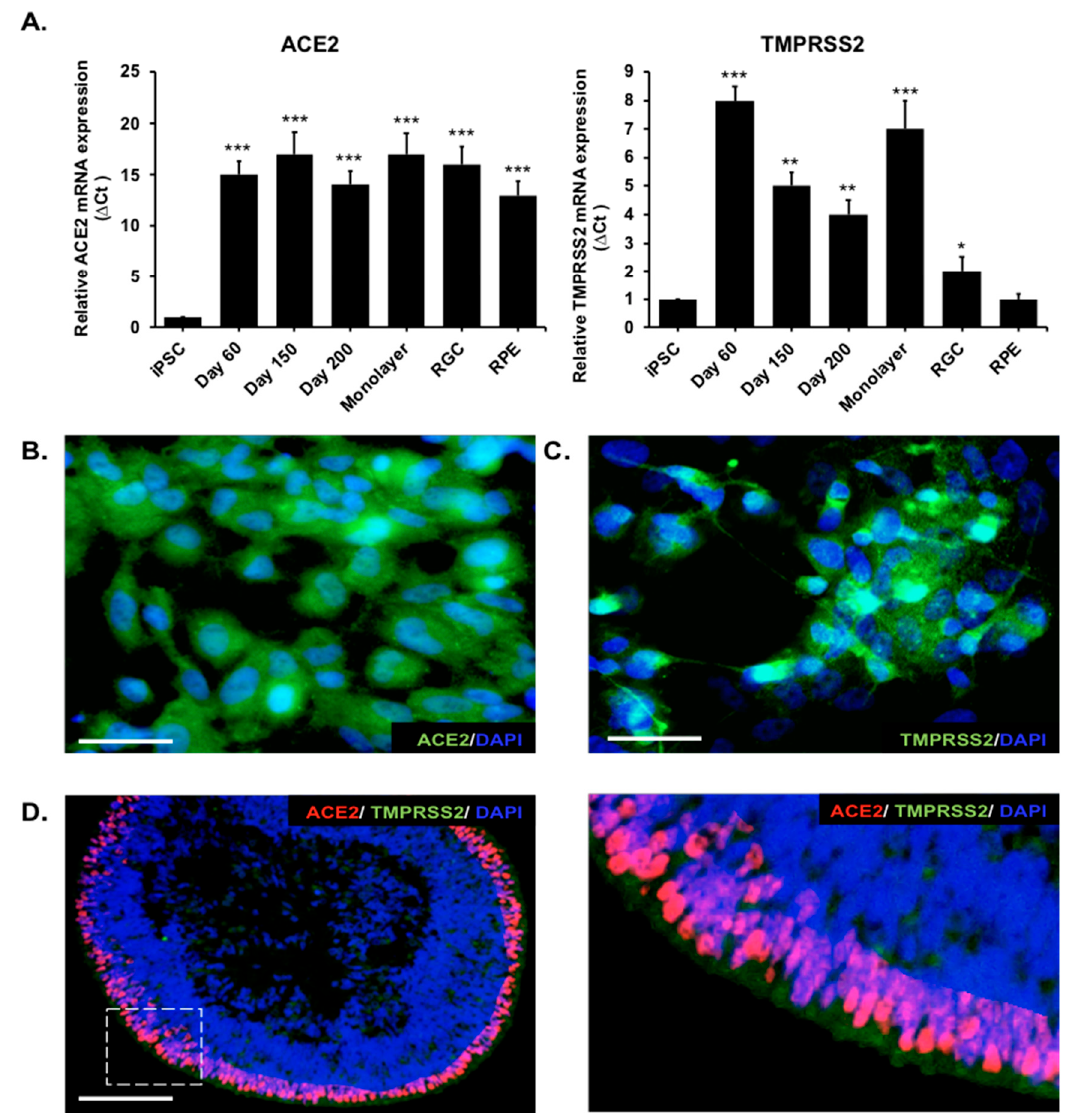
Figure 2. Analysis of angiotensin-converting enzyme 2 (ACE2) and transmembrane serine protease 2 (TMPRSS2) expressions on human iPSC-derived retinal organoids and monolayer cultures. ( A ) qPCR showing the ACE2 and TMPRSS2 gene expressions in retinal organoids (Day 60, Day 150, and Day 200); monolayer cultures; retinal ganglion cells (RGCs); and pigmented epithelium cells (RPEs). The expression of the housekeeping glyceraldehyde-3-phosphate dehydrogenase (GAPDH) gene was used for normalization. * p < 0.05, ** p < 0.01, and *** p < 0.001, and error bars are the standard deviation. ( B ) Immunofluorescence analysis of monolayer cultures with anti-ACE2. ACE2 expression was analyzed in monolayer cultures and stained in green at the cell membrane. Nuclei was stained positive for DAPI (blue). Scale bar, 50 µm. ( C ) The expression of TMPRSS2 (green) in the monolayer cultures. Cell nuclei was stained positive for DAPI. ( D ) The expression and localization of ACE2 and TMPRSS2 in Day-150 retinal organoids were evaluated by an immunofluorescence analysis. The area with ACE2 expression was stained in red and, with TMPRSS2 expression, stained in green. Nuclei were stained positive for DAPI. Right subpanel represents the boxed region of the image in the left subpanel with high magnification.